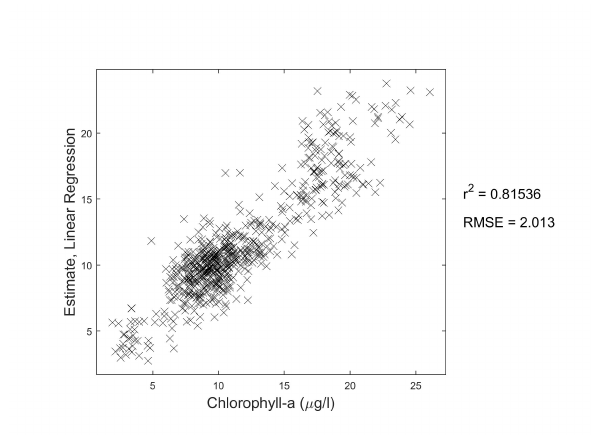
Figure 1. Linear regression estimate of Chlorophyll a concentration when DNs of all bands are used as